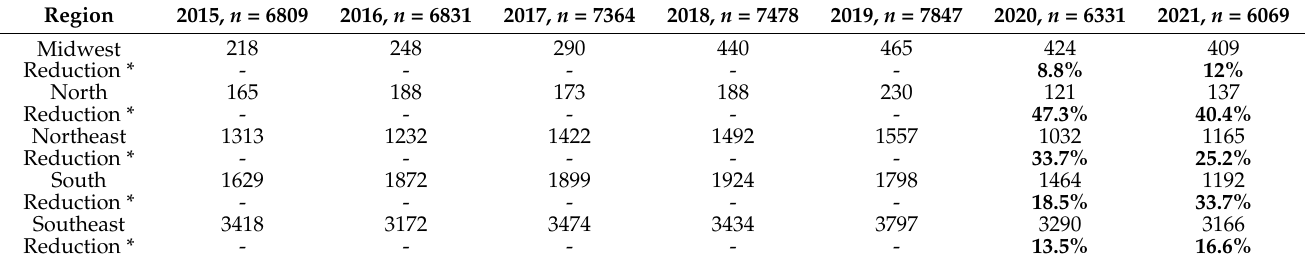
Table 3. Total number of solid organ transplants performed in Brazil’s Unified Healthcare System (SUS) from 2015 to 2021 by region.